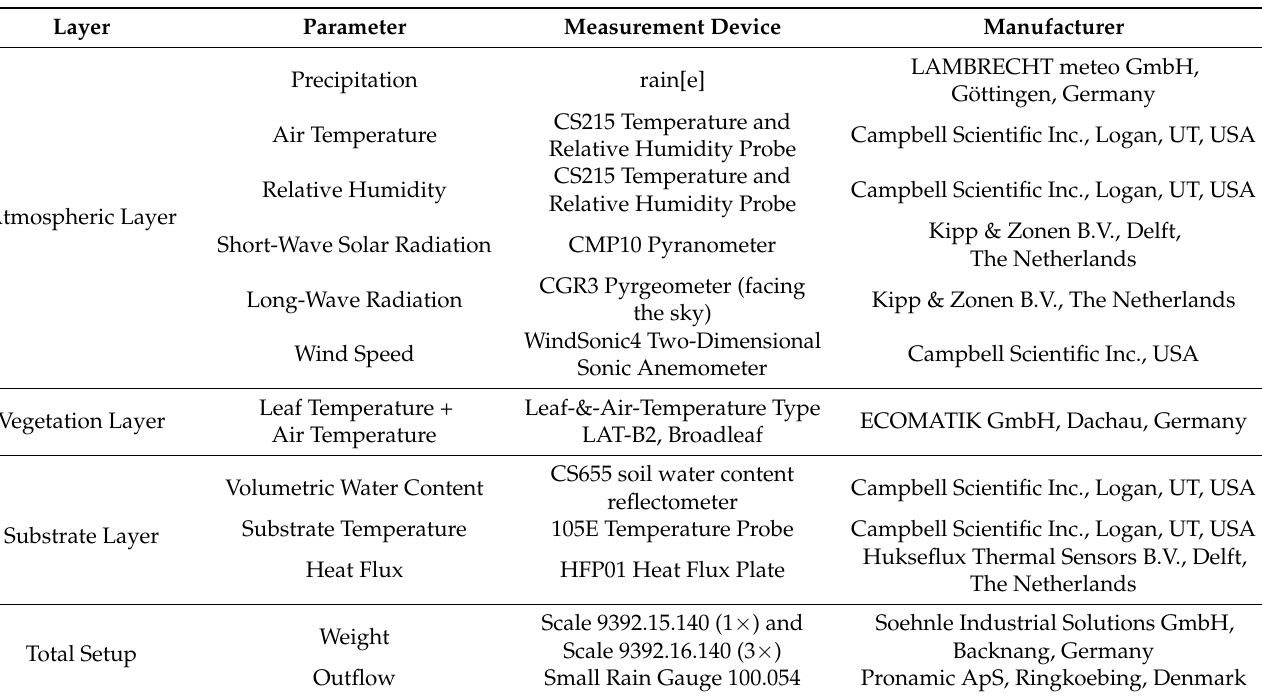
Table 1. List of parameters measured, the installed measurement devices and approximate position of the sensors.